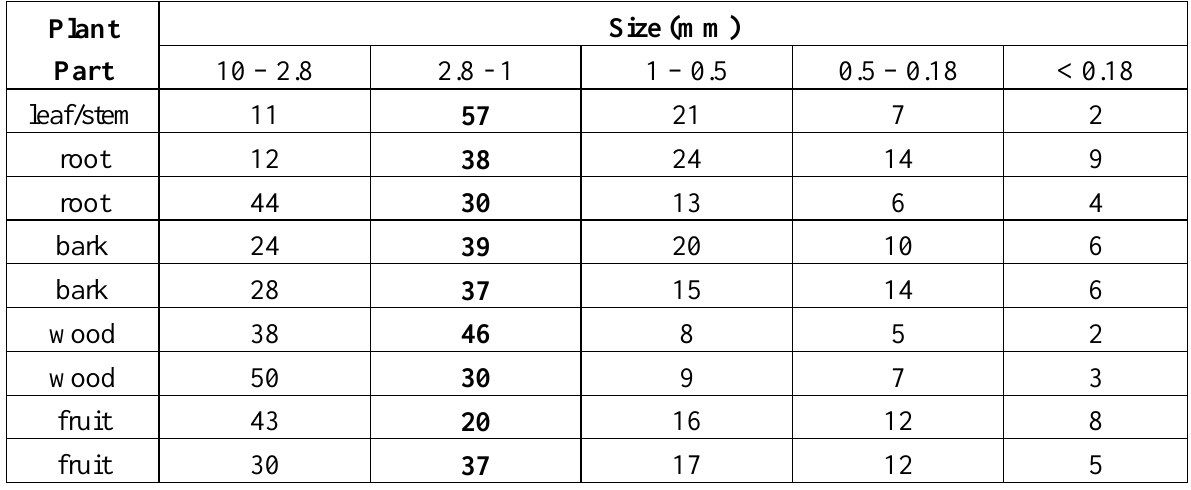
Table 1. Particle size distribution for nine plant samples, expressed as a